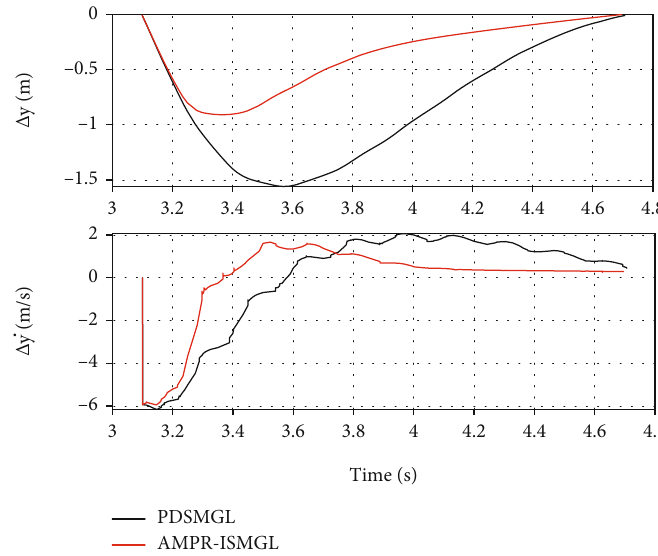
Figure 10: Trajectory deviation and deviation rate